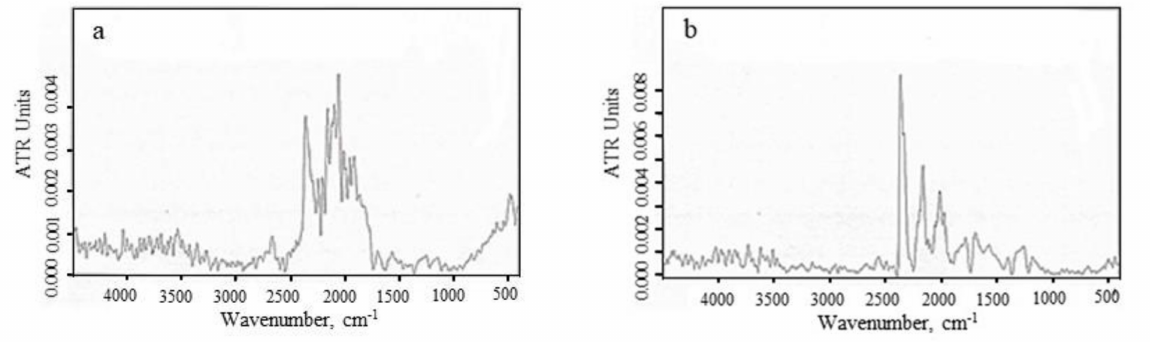
Figure 6. FTIR spectra of: ( a ) 1200 ◦ C (C-5) and ( b ) 1400 ◦ C (C-15)